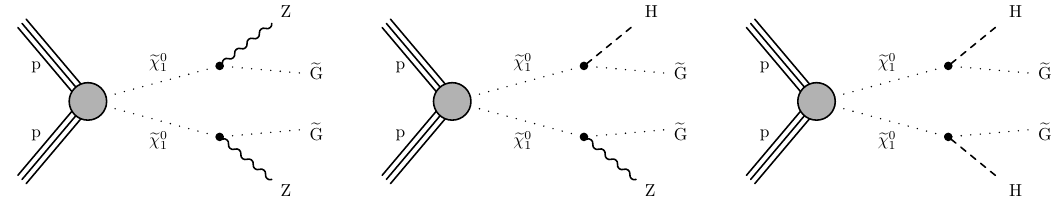
pair production with decays mediated by Z or H Figure 3 . Effective e c 0 1